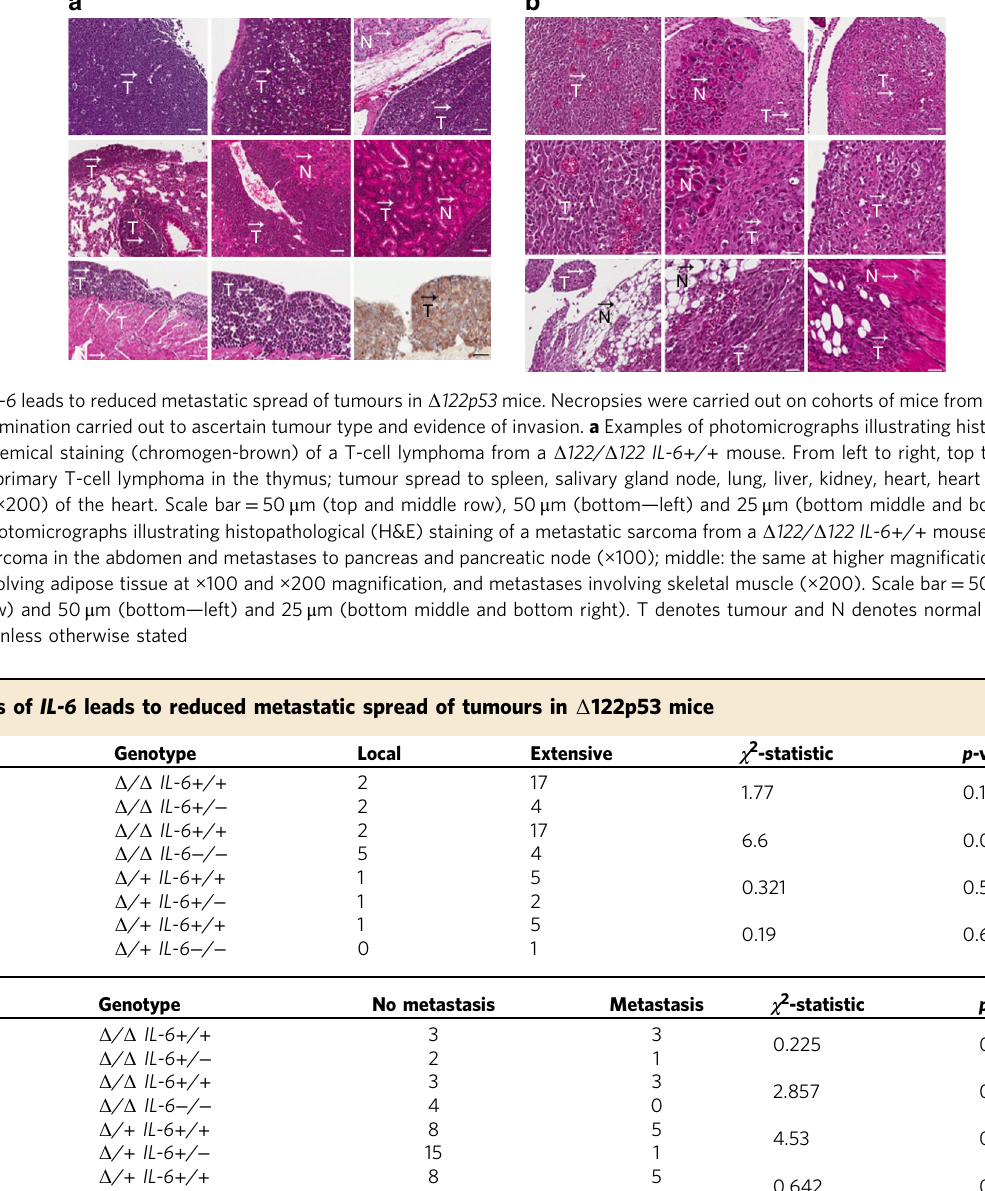
Summary of χ 2 -statistic and p -value for local vs. extensive organ involvement by T lymphomas between the genotypes and number of metastasis of sarcomas between the genotypes * p < 0.05 was considered to be signi fi